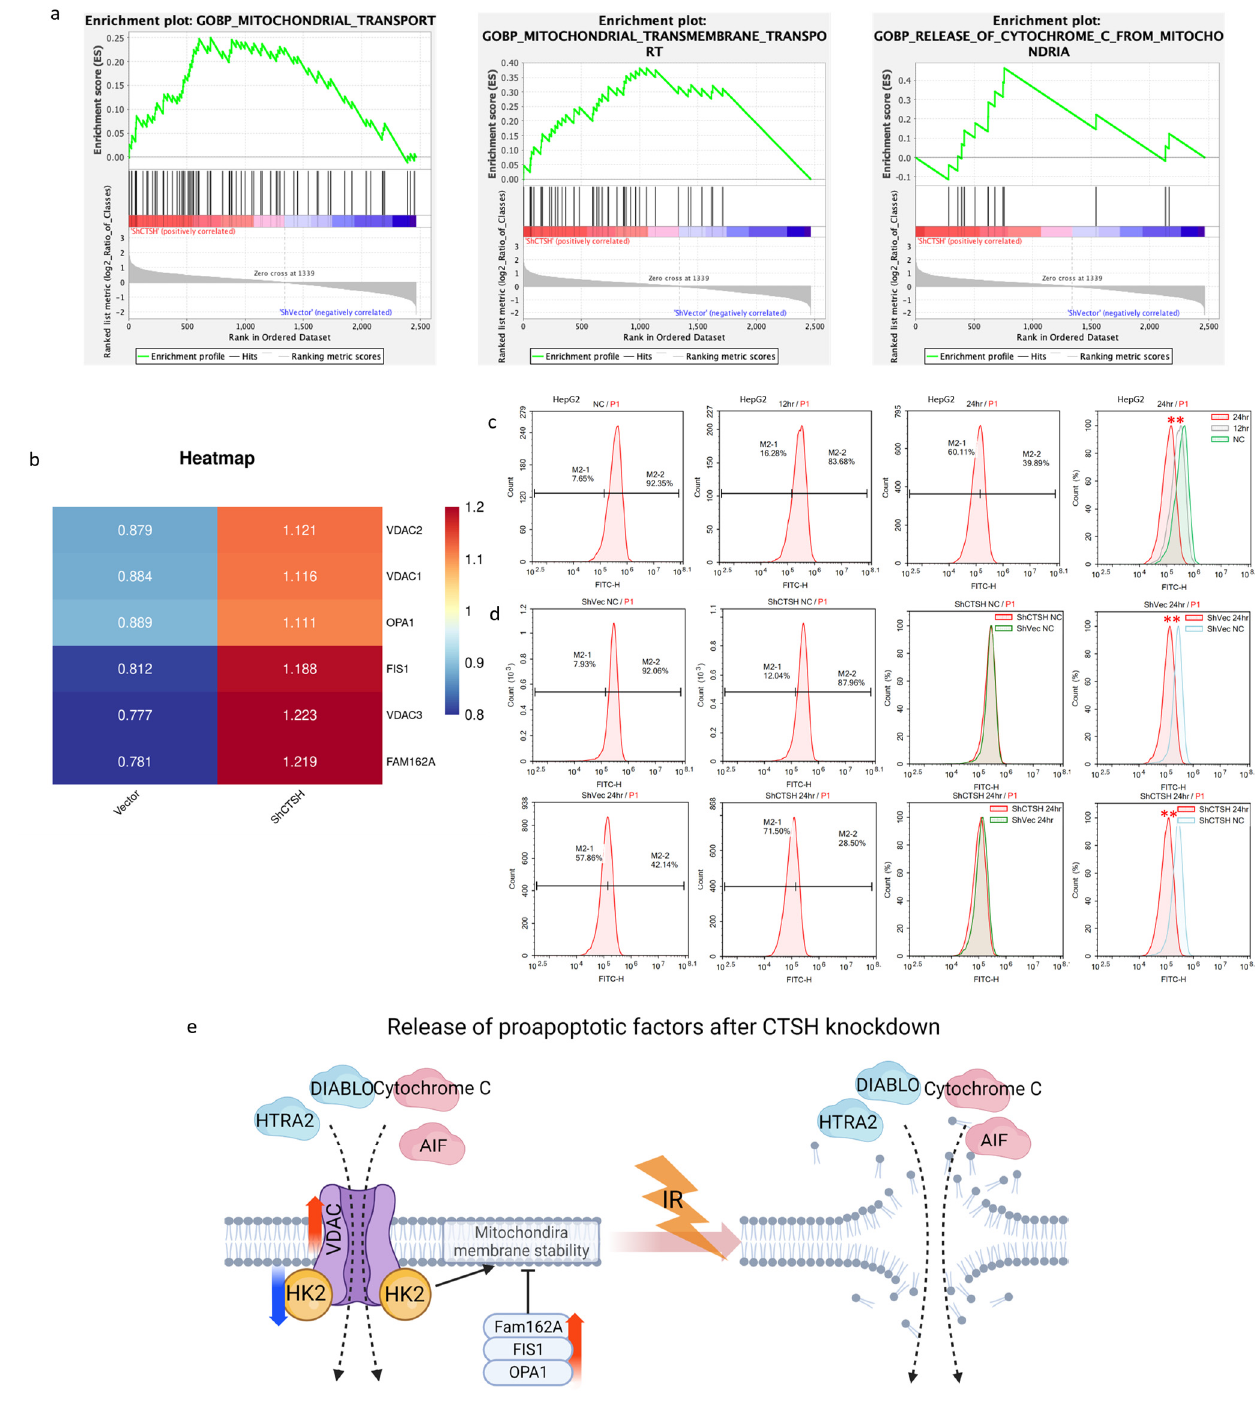
Figure 5. CTSH Knockdown Changed Mitochondrial Membrane Permeability and Stability in Proapoptotic Signaling. ( a ) GSEA results showing the up-regulation of the transmembrane transport of mitochondria and the release of cytochrome c biological processes (BPs) after CTSH knockdown ( p < 0.05); ( b ) Increase in the VDAC family, Fam162A, FIS1, and OPA1 in protein level after CTSH knockdown detected by mass spectrometry; ( c ) Mitochondrial membrane potential (MMP) of wildtype HepG2 cells with and without IR treatment detected by flow cytometry ( p < 0.05); ( d ) Mi- tochondrial membrane potential of CTSH vector/knockdown HepG2 cells with and without IR treatment detected by flow cytometry ( p < 0.05); ( e ) Graphical abstract of the above findings and the corresponding changes in protein level. ** p < 0.05.